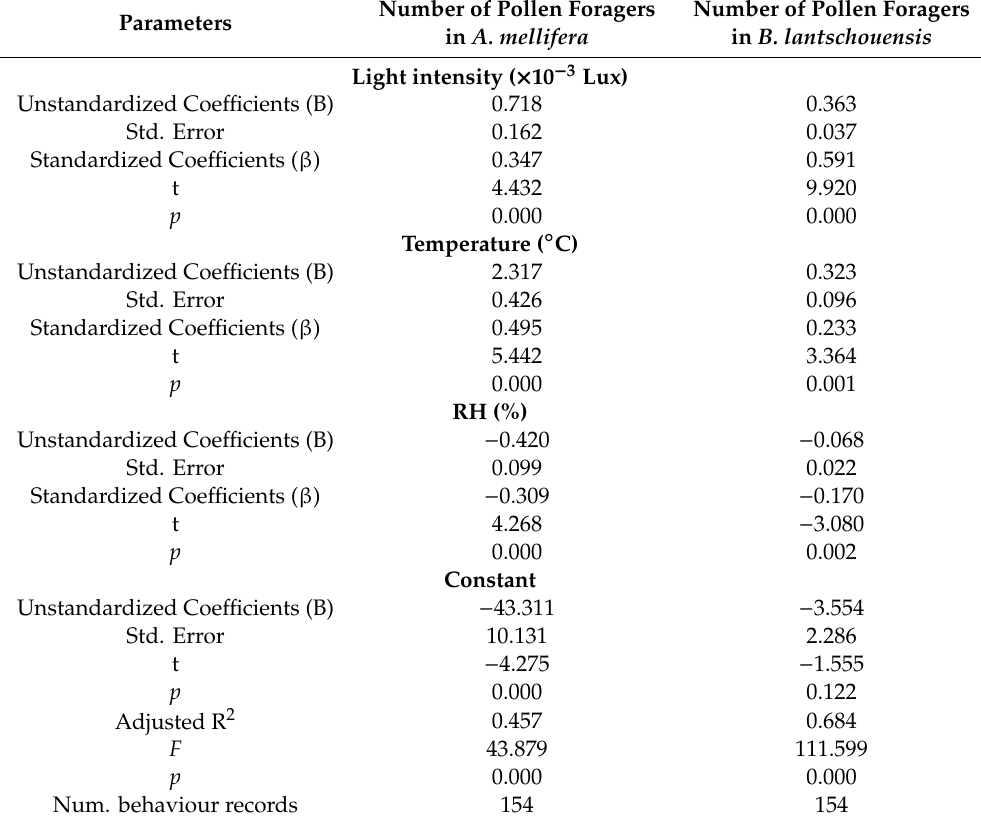
Table 1. E ff ect of light intensity, temperature and RH on pollen-collecting activity of Apis mellifera and Bombus lantschouensis . The model to predict honeybee pollen-collecting activity was as follows: number of pollen foragers = 0.718 light intensity ( × 10 − 3 lux) + 2.317 temperature ( ◦ C) − 0.420 RH (%) − 43.311. The model to predict bumblebee pollen-collecting activity was as follows: number of